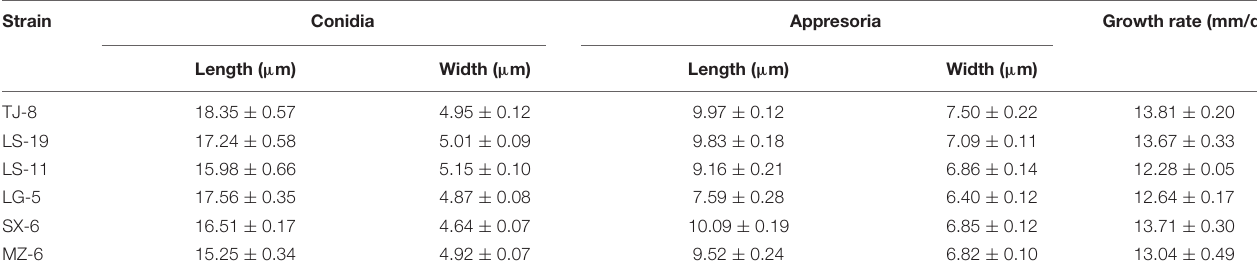
TABLE 3 | Synopsis of morphological data of Colletotrichum